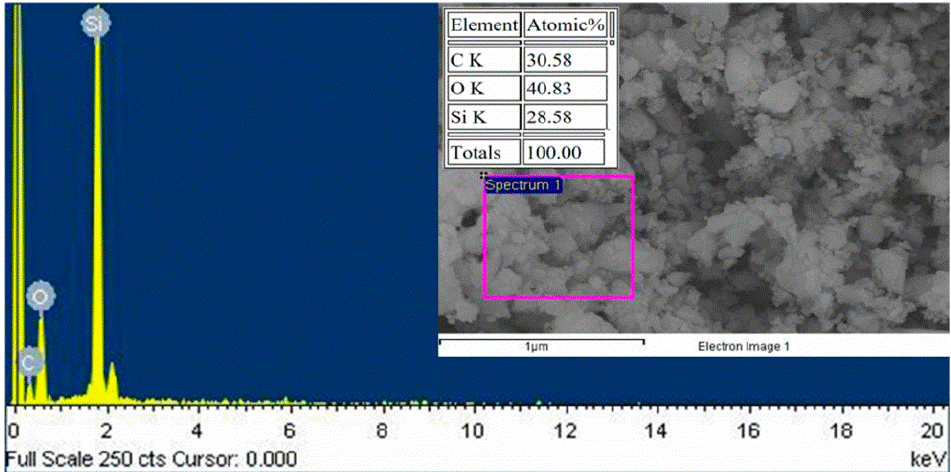
Figure 5. Micrograph of SiNPs from SEM-EDS.